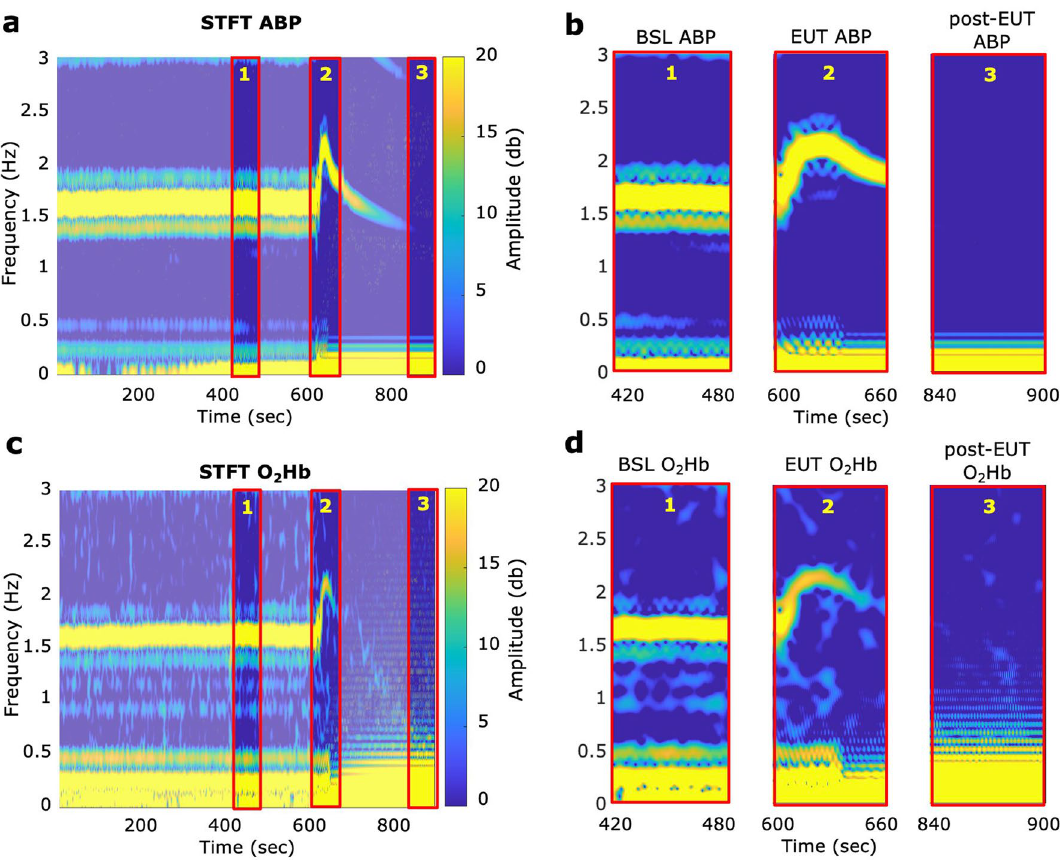
Figure 5. Representative short-time Fourier transform analyses. STFT colormaps of ( a ) carotid ABP and ( c ) NIRS O 2 Hb signals over a 15-min window. Pentobarbital infusion commenced at 600 s. ( b , d ) Three analysis windows were selected for subsequent analysis, denoting different stages of euthanasia. O 2 Hb oxygenated hemoglobin, ABP arterial blood pressure, BSL baseline, EUT euthanasia, STFT short time Fourier transform (for STFT colourmaps from individual animals, see Supplementary Figs. 1–8).